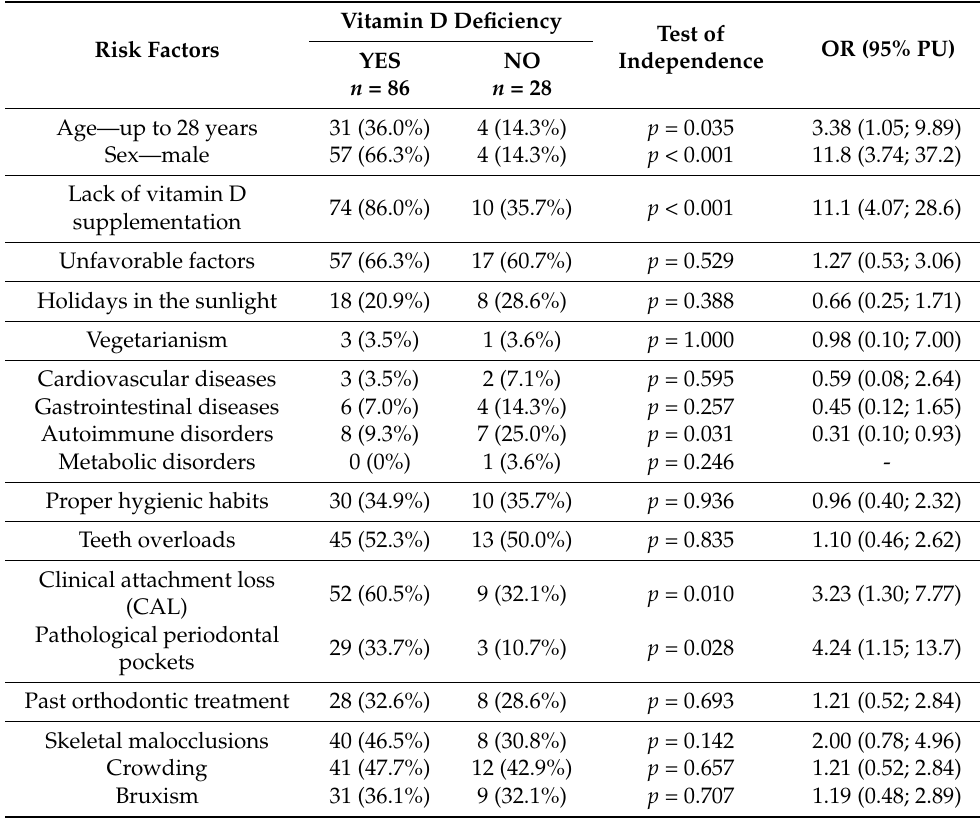
Table 3. Comparison of qualitative characteristics of patients differing in vitamin D3 levels and test results.